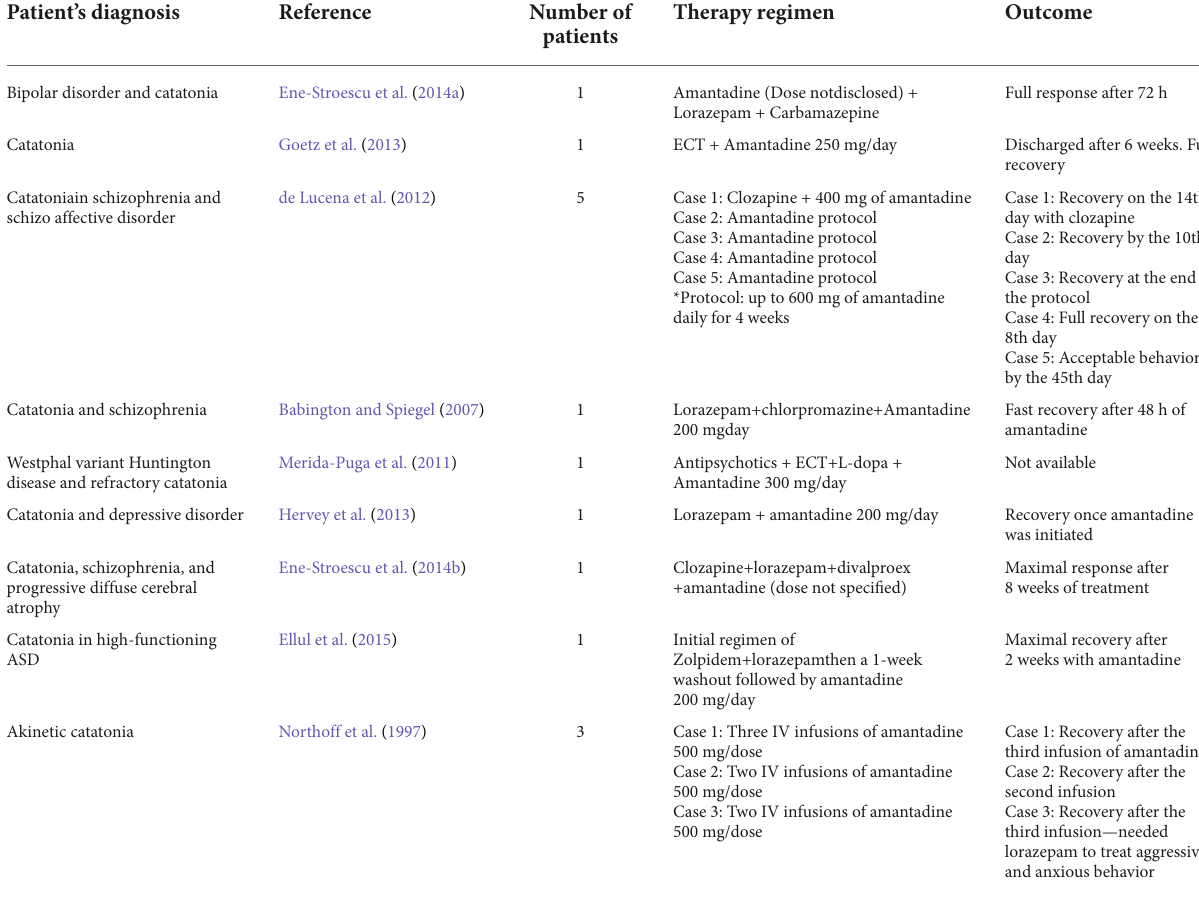
TABLE 2 Successful cases reported using amantadine, therapy regimen, and